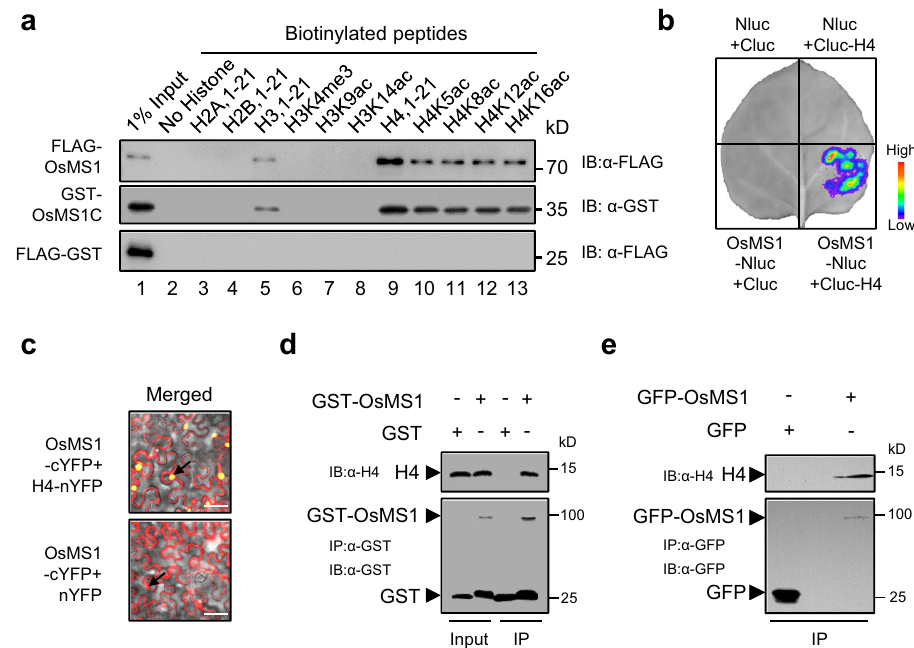
Fig. 2 OsMS1 is a histone binding protein. a In vitro histone pull-down assay with the indicated proteins against biotinylated peptides. Proteins were pulled down by strepavidin beads and detected by western blots with antibody against FLAG or GST. b OsMS1 associates with H4 in a LCI assay. The indicated constructs were transiently expressed in N. benthamiana at 22 °C for 48 h. Luciferase activity is depicted with false color from low (blue) to high (red). Nluc, N-terminal half of fi re fl y luciferase; Cluc, C-terminal half of fi re fl y luciferase. c OsMS1 associates with H4 in a BiFC assay. Assays were done as in ( b ). nYFP, N-terminal portion of YFP; cYFP, C-terminal portion of YFP. Black arrows indicate nuclei. Scale bars, 50 μ m. d OsMS1 associates with H4 in a semi- in vivo pull-down assay. GST-OsMS1 was incubated with nuclear proteins extracts from stage 9 anthers of rice young panicles. Proteins were pulled down by Glutathione sepharose beads and detected by western blots with antibody against GST or H4. e OsMS1 associates with H4 in a co-immunoprecipitation assay. Proteins extracts from stage 9 anthers of transgenic 35S:GFP-OsMS1 rice was immunoprecipitated with a GFP-Trap ® _A agarose beads and detected by western blots with antibody against GFP or H4. 35S:GFP transgenic rice was used as a negative control. Experiments were repeated more than three times with similar results. Source data are provided as a Source data fi